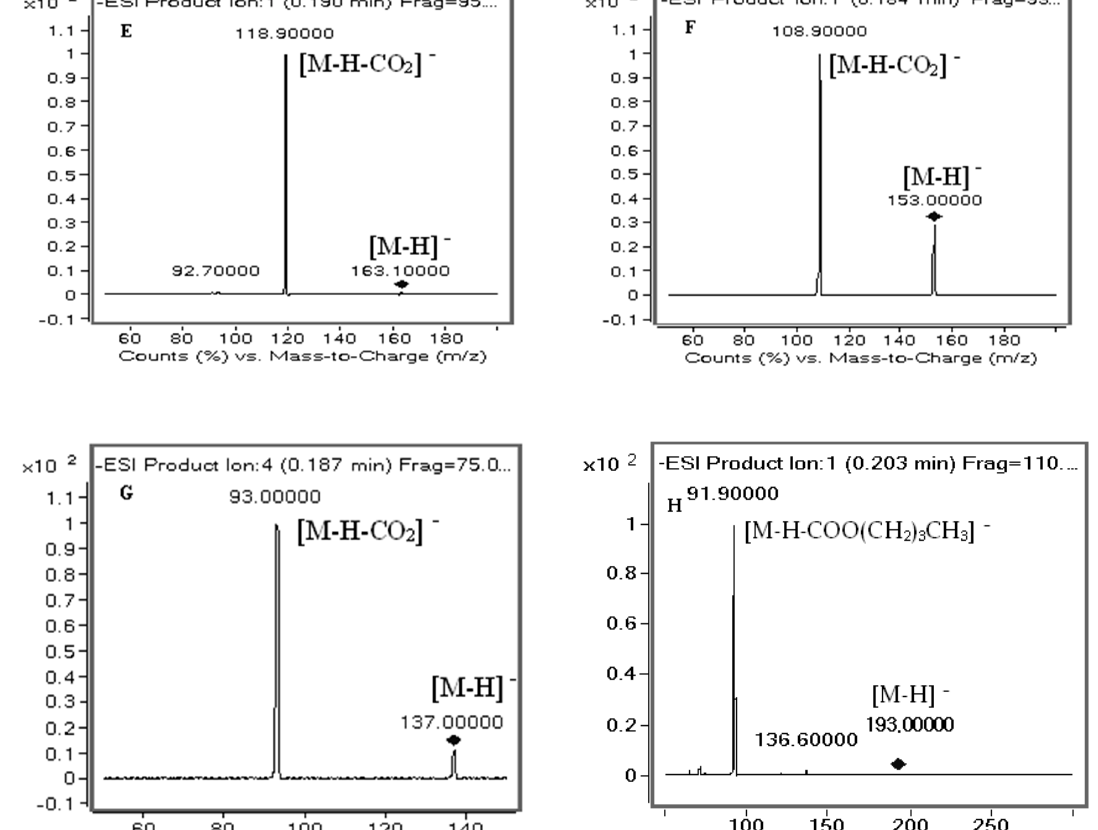
Figure 4. Product ion mass spectra of the seven analytes and IS: ( A ) syringic acid; ( B ) ferulic acid; ( C ) caffeic acid; ( D ) vanillic acid; ( E ) p -coumaric acid; ( F ) 3,4-dihydroxybenzoic acid; ( G ) 4-hydroxy benzoic acid; ( H ) butylparaben.